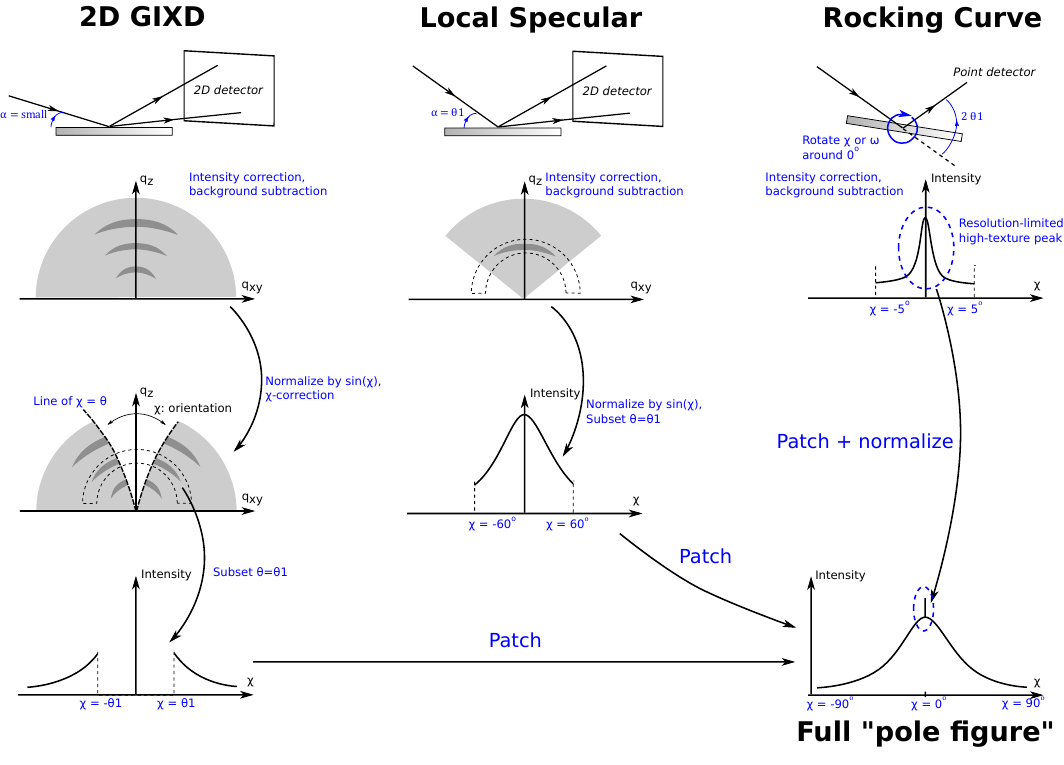
Figure 7. Illustration of the steps to create a full pole-figure in χ for uniaxially-textured thin-film samples. The final data is patched from three different measurements: a 2D GIXD, a “local specular”, and a rocking curve. θ 1 is the angle corresponding to the (cid:126) q of interest. First, each data set is properly intensity-corrected and background subtracted. Note that data from rocking curve may not contain the peak from highly-textured part of the sample as described in the figure. Data from 2D GIXD is then transformed to correct χ and its intensity is normalized by sin ( χ ) to correct for geometrical factor. Next, all 2D data are then subset around θ 1. Lastly, all three data sets are patched